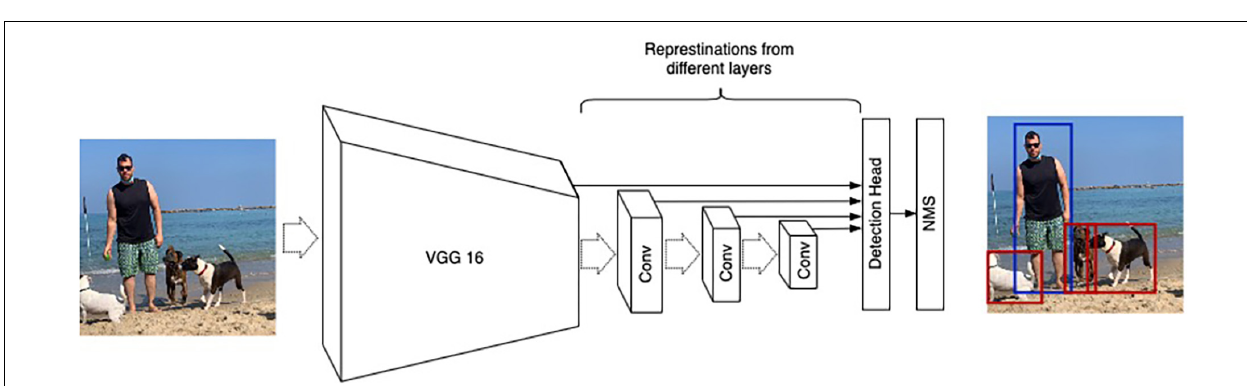
FIGURE 4 | SSD architecture illustration. VGG16 (Simonyan and Zisserman, 2014) is used as a base network. Detection heads are connected to numerous convolution layers (denoted as “Conv”) to account for different resolutions.